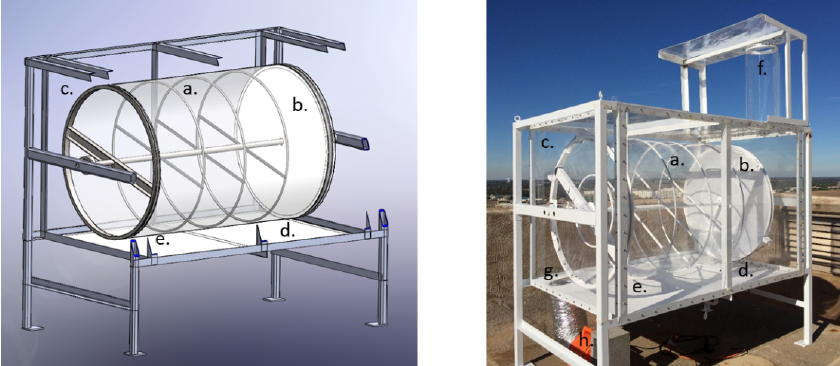
Figure 1. Sketch and photo of a CAGE chamber.